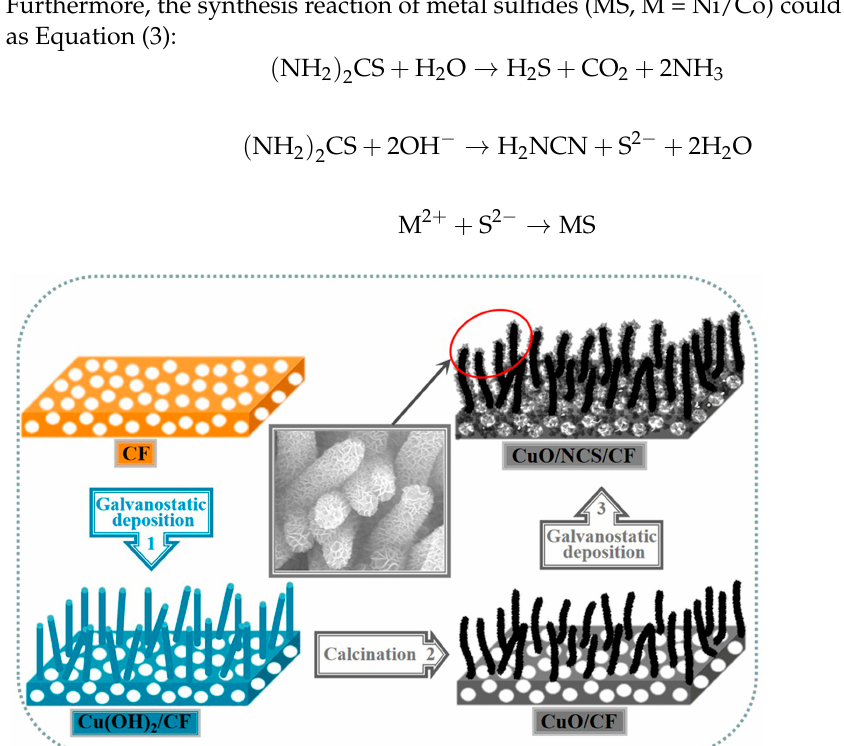
Figure 1. The design process of CuO/NCS electrode. That is, in the initial stage of electrodeposition, the S 2 − was generated on the surface of the CuO electrode by hydrolysis of thiourea, which was captured by the Ni 2+ /Co 2+ to growth surface. The two-step potentiostatic deposition curves are shown in Figure 2.